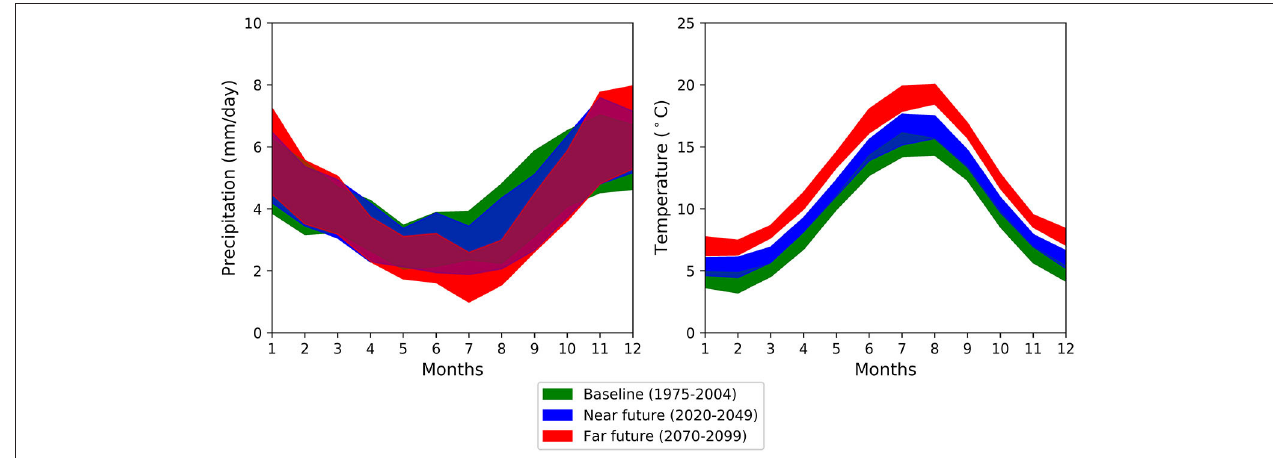
FIGURE 3 | Precipitation and temperature projections (w@h2) for the Plynlimon catchment.